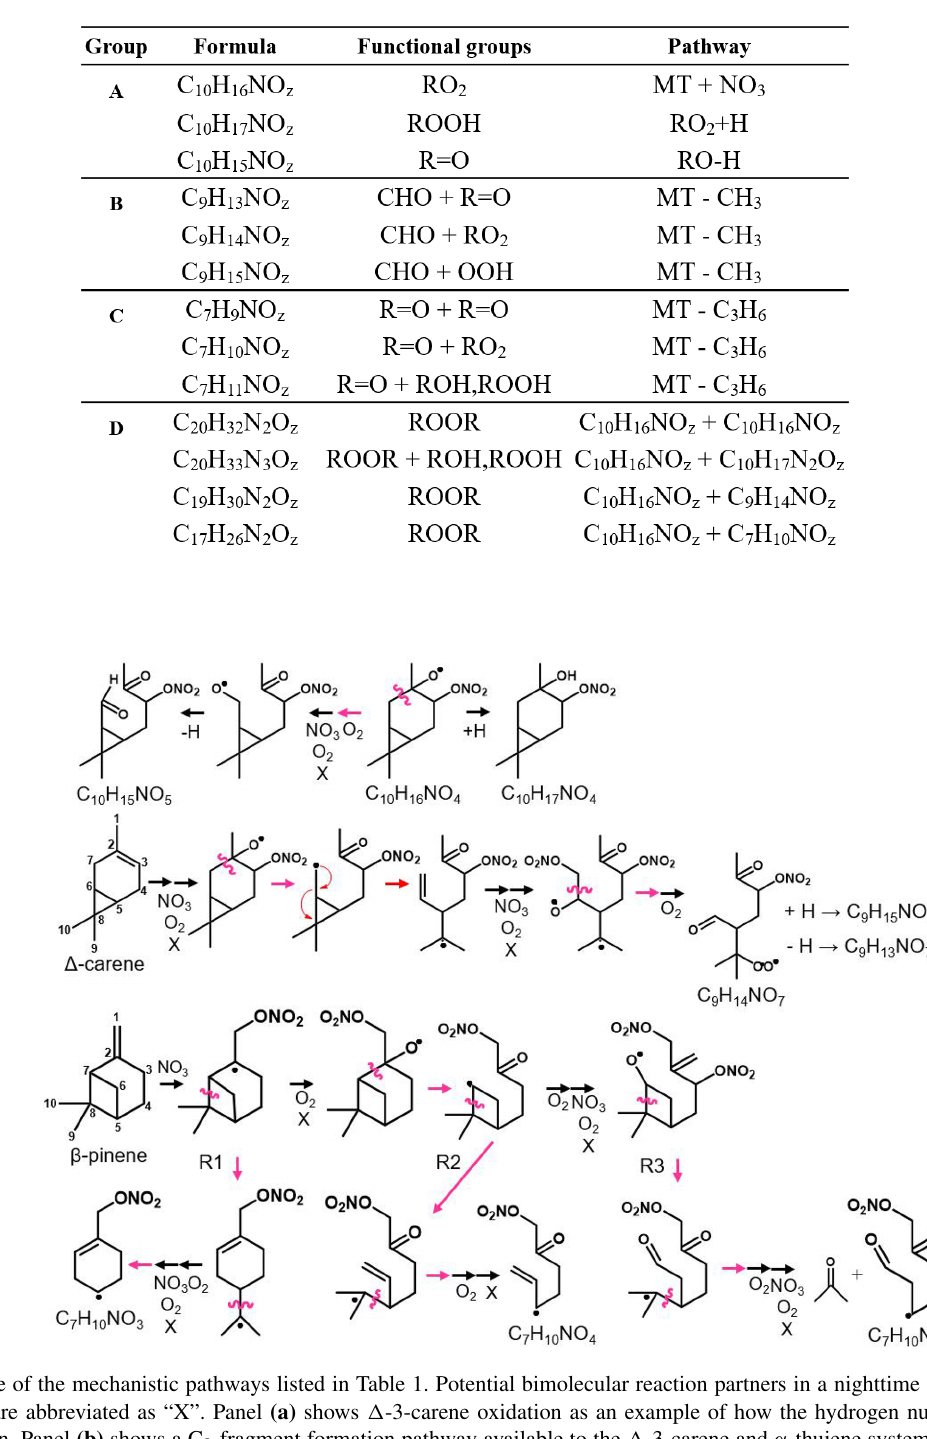
Table 1. Summary table of reaction product formulas grouped by the mechanistic pathways shown in Fig. 5. Group A details the formation